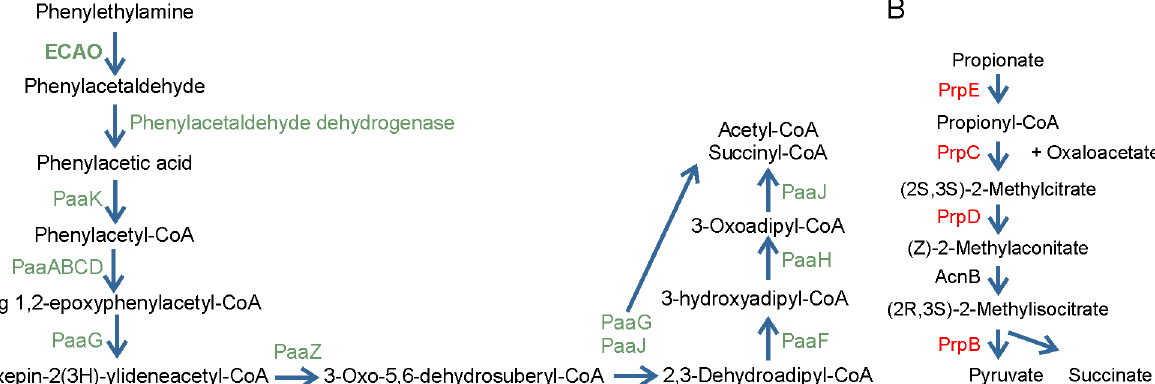
Fig 3. Pathways altered by tynA knockout. ( A) The phenylethylamine metabolic pathway is down-regulated (green) in the Δ tynA strain when compared to the wt strain in M9-lactose-PEA medium. (B) The oxidation of propionate to pyruvate is up-regulated (red) in the Δ tynA strain. Pathways are depicted according to Brock et al . and Zeng et al . [5,41].